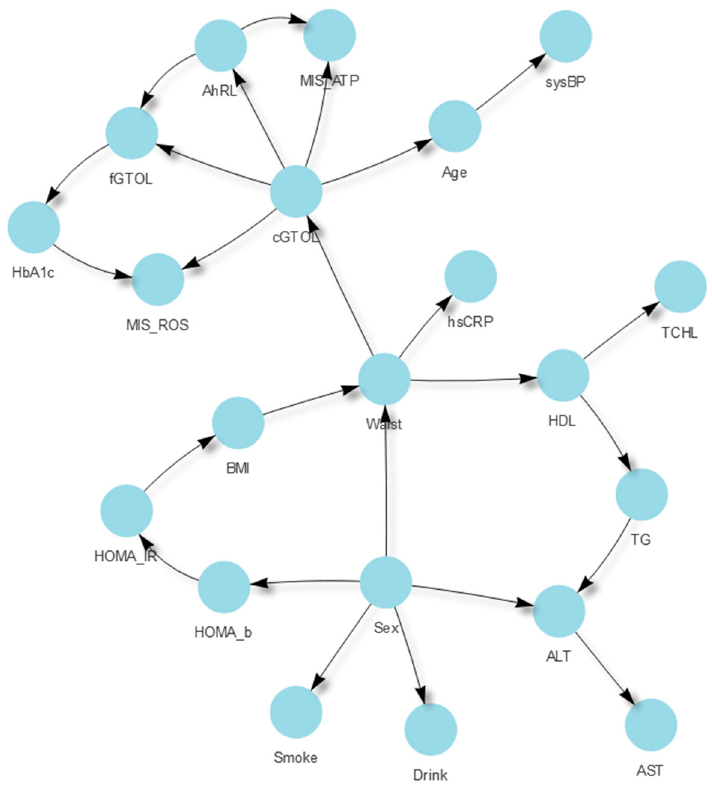
Figure 6. GBN structure on the variables. GBN assumed no structural constraint. Variables connected by edges are conditionally dependent on each other.